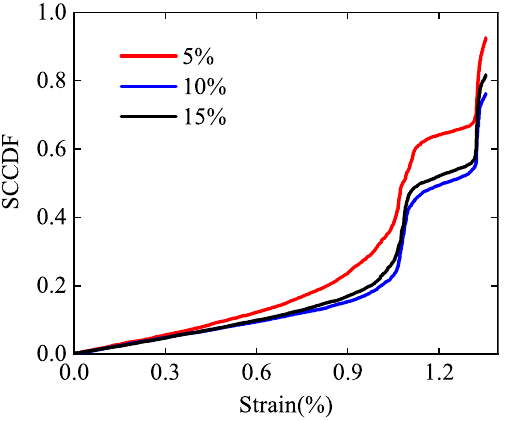
Figure 8. Variation in the SCCDF with loading for the specimen No. 60-1: the top 5%, 10%, and 15% of the τ xy strain